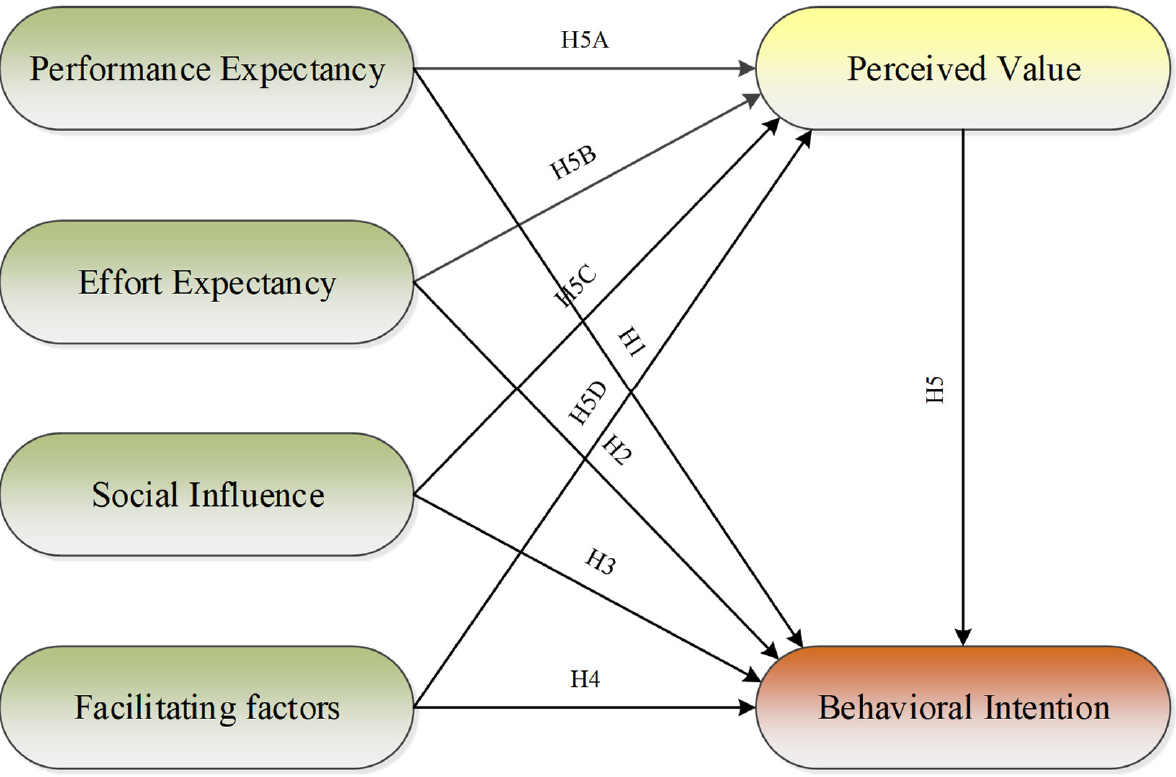
Figure 1. Conceptual framework.